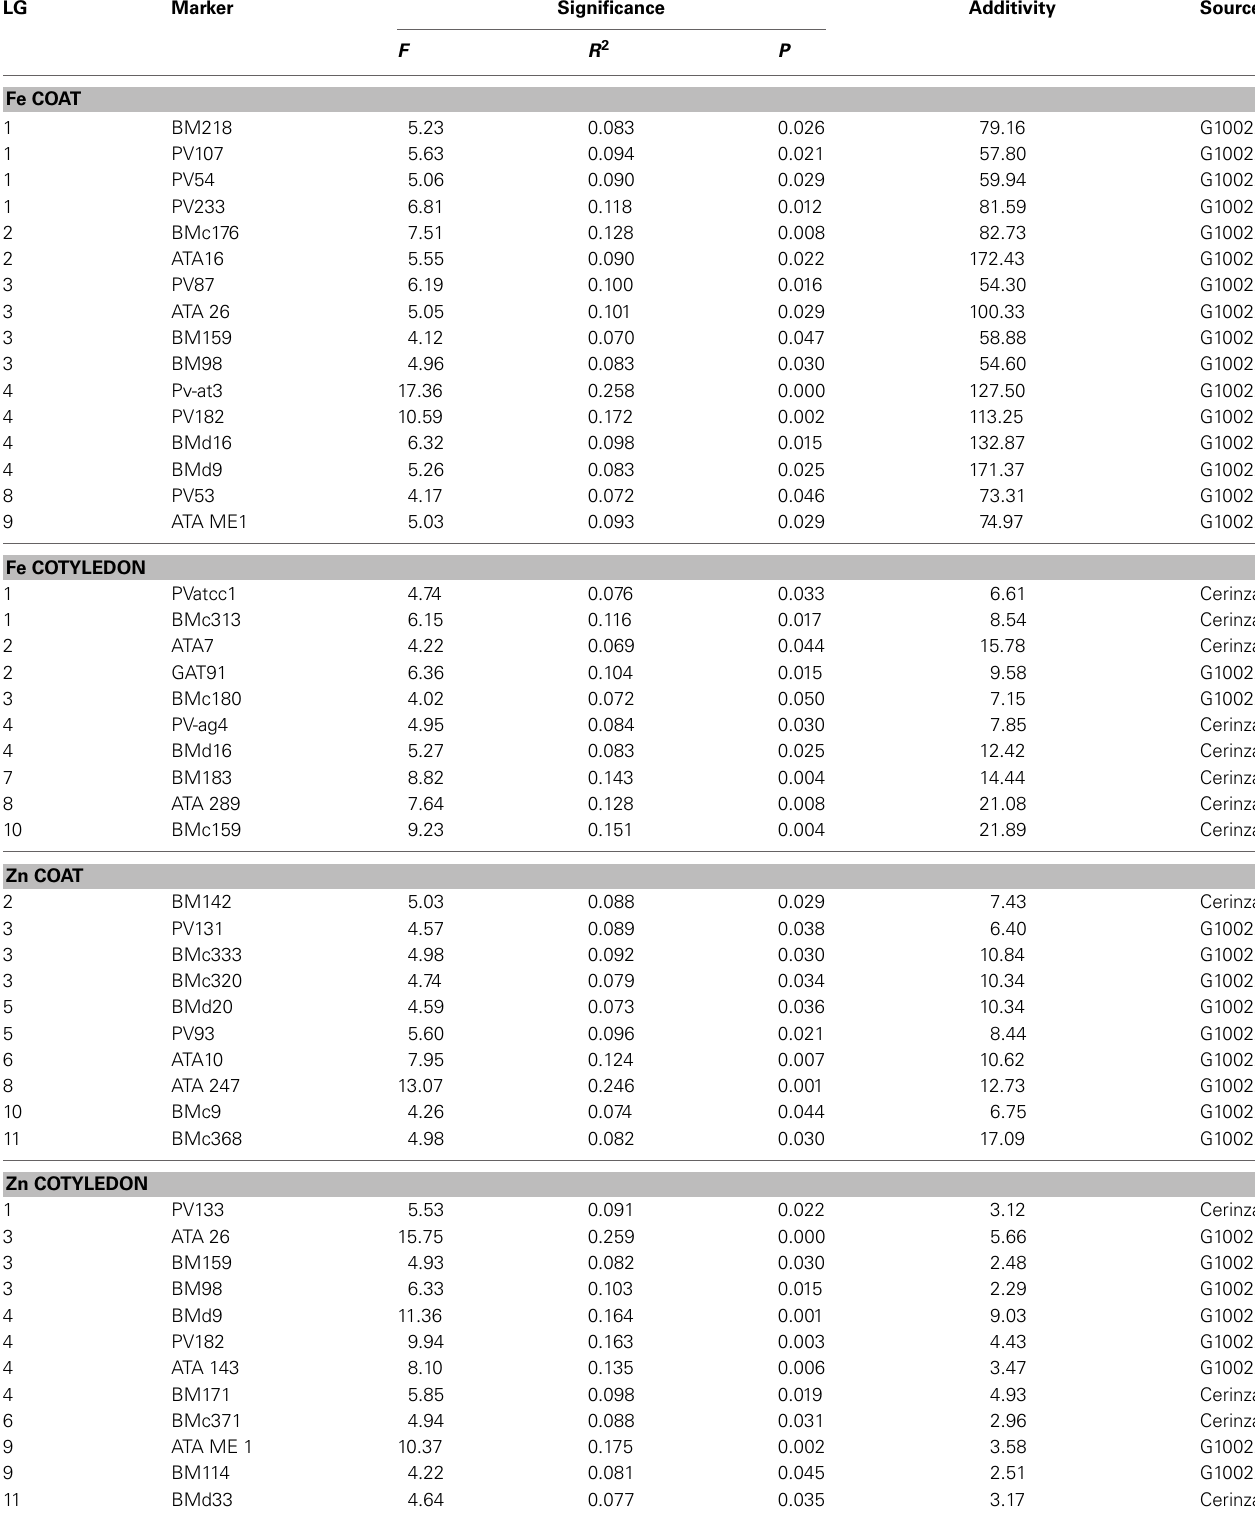
Table 5 | Quantitative trait loci for seed coat or cotylendon iron (Fe) and zinc (Zn) concentration identified by single point analysis (SPA) in the advanced backcross population derived from the wild donor parent (G10022) and the recurrent cultivated parent (Cerinza). LG Marker Significance Additivity